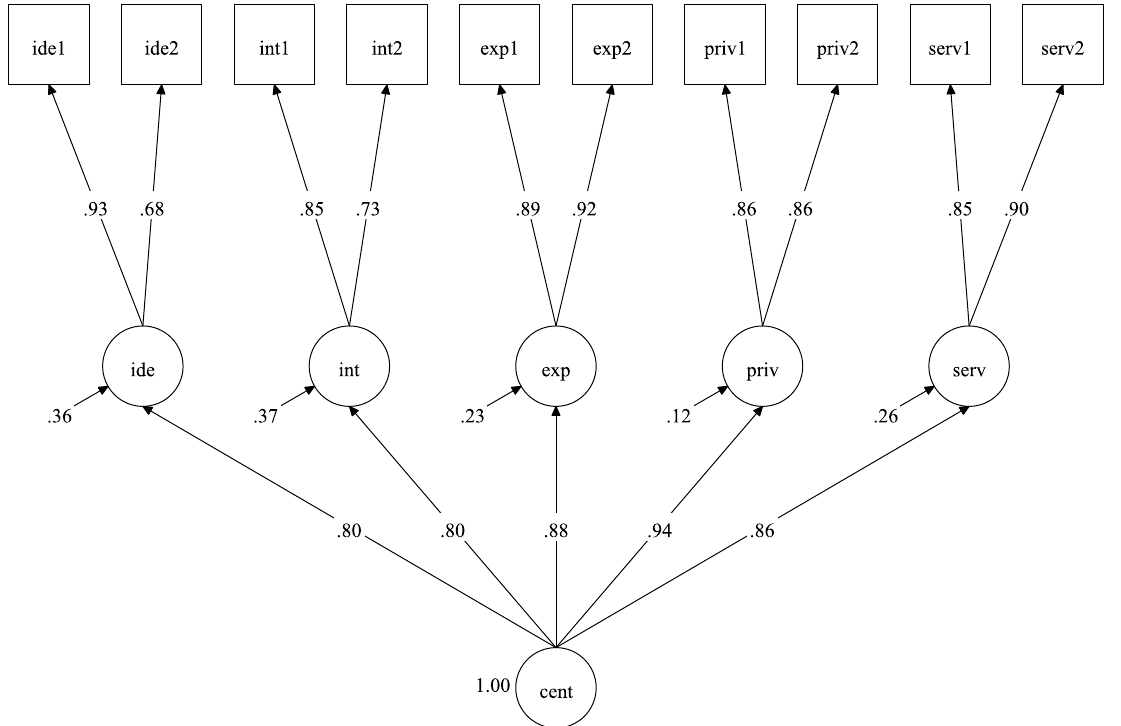
Figure A5. Results of the confirmatory factor analysis of the CRS-10. The numbers in the plot represent standardized estimates. Cent = centrality of religiosity; int = intellect; ide = ideology; serv = public practice; priv = private practice; exp = experience. The number after the item name indicates the position of the item within the core dimension items. Squares depict manifest and circles latent variables. Residual arrows are not shown for the manifest variables. Numbers on arrows are factor loadings. The model is identified by setting the variance of the second level latent variable “cent” and the factor loading of each item with the suffix “1” to be equal 1. All reported estimates are significant at least α ≤ 0.05 level.